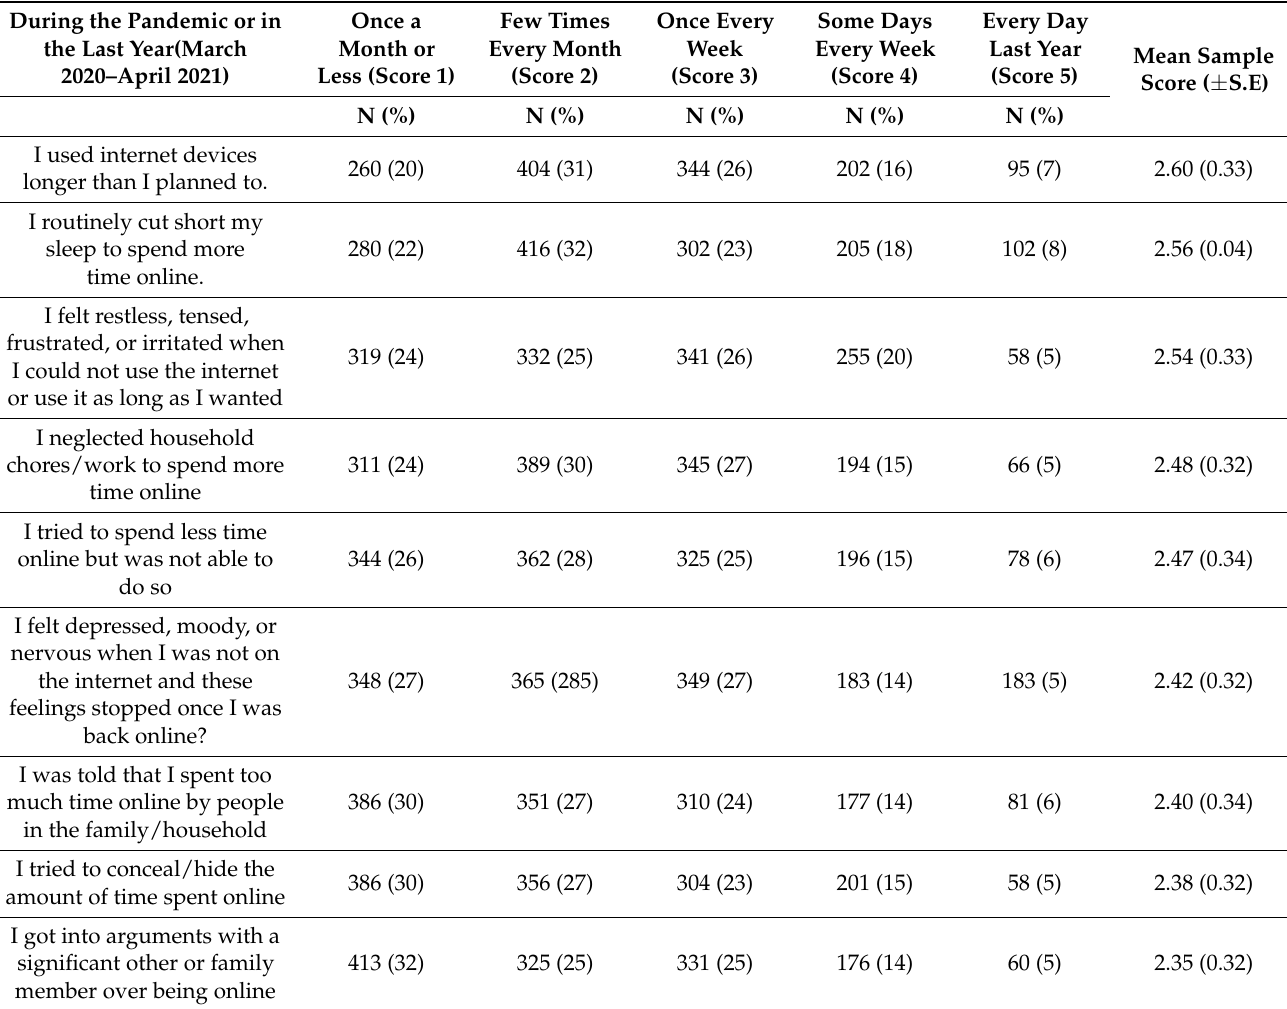
Table 1. Distribution of Responses to Internet Addiction Questions Among Study Participants (N = 1305). During the Pandemic or